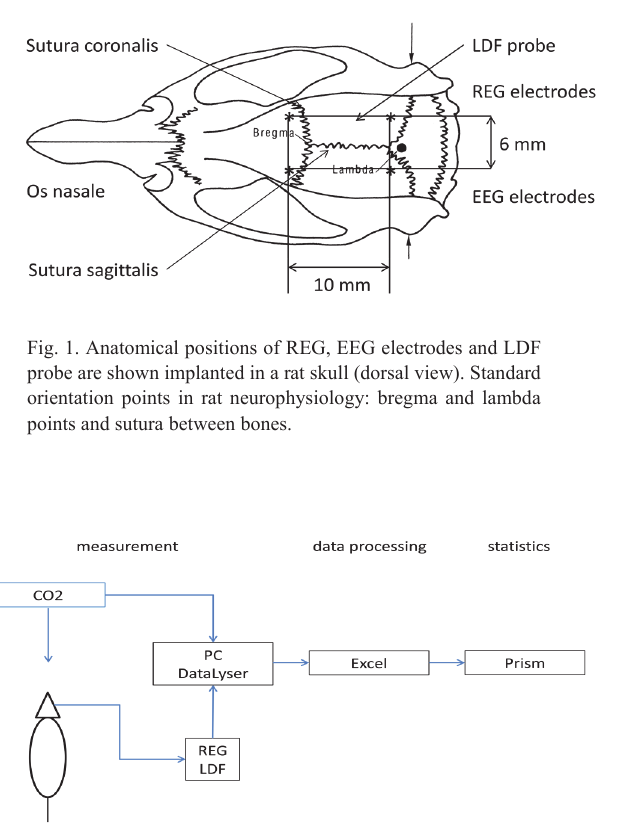
Fig. 2. Block schematics showing REG and LDF measured during rat CO 2 inhalation challenges and data processing of resulting signals stored in a computer (PC). Data were first processed using DataLyser software to process analog signals; numbers generated were then put into an Excel software spread sheet for calculation of percentages of control values, group mean and SD. Next, percent values of REG and LDF were put into a Prism software spreadsheet for calculation of ROC and